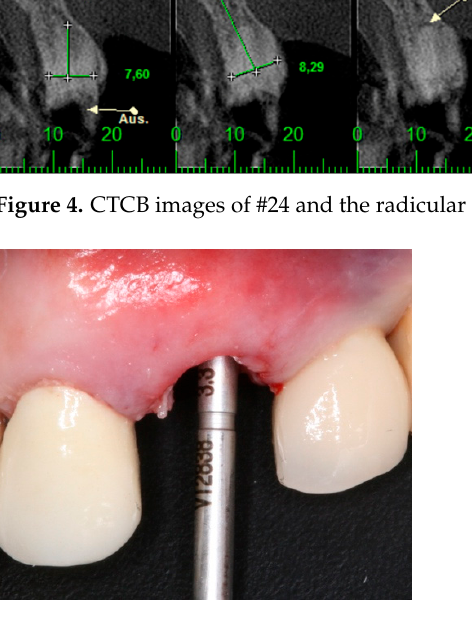
Figure 5. Intraoral buccal view of Versah drill VT2838(3.3) on #24 after site instrumentation.